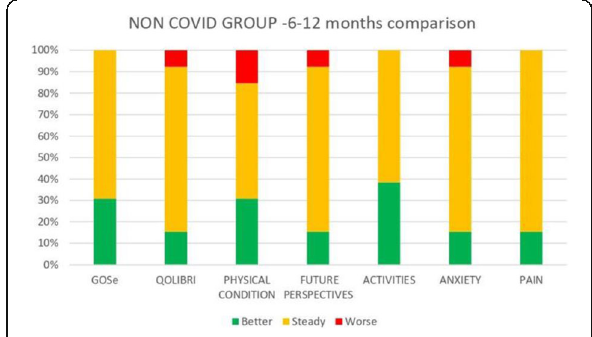
Fig. 1 (abstract A95). Summary of trends in the non-Covid